Question: In a single sentence, describe what this figure presents.
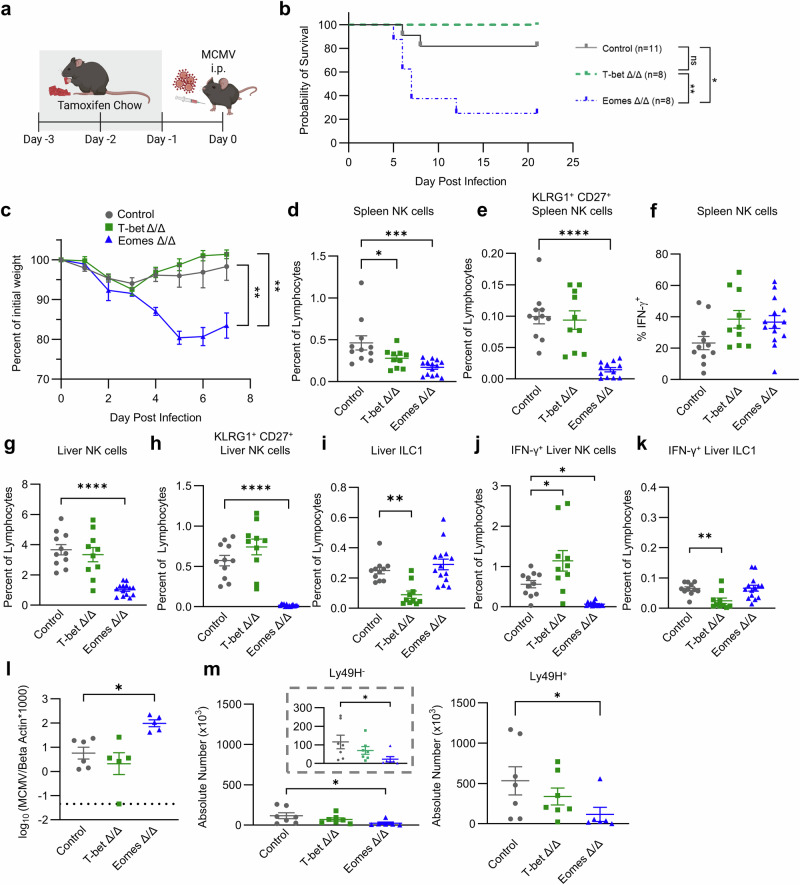
Answer: T-bet is dispensable while Eomes is required for protective group 1 ILC mediated murine cytomegalovirus (MCMV) response. a Schema. Ncr1 -iCreER T2 x Rosa26- YFP LSL x Tbx21 fl/fl (T-bet Δ/Δ), Ncr1 -iCreER T2 x Rosa26- YFP LSL x Eomes fl/fl (Eomes Δ/Δ), and N cr1 -iCreER T2 x Rosa26 -YFP LSL (control) mice were fed tamoxifen chow for 3 days. The day after tamoxifen chow was removed, the mice were infected with b , 2 ×105 pfu or (c-m) 5 ×104 pfu MCMV. Schema created in BioRender. Fehniger, T. (2026) https://BioRender.com/x3jcenb . b Kaplan-Meier survival curve ( n = 8–11 per group, female mice only). c Summary weigh loss data ( n = 4–6 per group). Summary data of d , YFP + NK cell (CD3 - NK1.1 + NKp46 + ) percentage within splenic lymphocytes ( n = 10–14 per group), e KLRG1 + CD27 + YFP + NK cells percentage within splenic lymphocytes ( n = 10–12 per group), and f percentage of IFN-γ + splenic YFP + NK cells ( n = 10–14 per group) at 1.5 days post MCMV infection. g – i percent of g, YFP + NK cell ( n = 10-14 per group), h, KLRG1 + CD27 + YFP + NK cell ( n = 10–14 per group), and i, ILC1 within lymphocytes in the liver ( n = 10–14 per group). j , k percent of IFN-γ + NK cell ( n = 10-14 per group) and ILC1 ( n = 10-14 per group) within lymphocytes in the liver. l, MCMV titer measured as IE1 copy number per Beta actin *1000 in the spleen on 4 days post infection ( n = 5–6 per group). m Absolute numbers of Ly49H - and Ly49H + NK cells in the spleen 7 days post infection ( n = 6–7 per group). Statistical significance was determined by Mantel-Cox test in b , Mixed-effect analysis with Šidák’s multiple comparison test in c for adjusted p-values, and one-way ANOVA with Dunnett’s multiple-comparisons test in d-l and Kruskal-Wallis test with Dunn’s multiple comparisons in m for adjusted p-values. 2–4 independent experiments. * = p < 0.05, ** = p < 0.01, *** p = < 0.01, **** = p < 0.0001. Exact p-values are provided in the Source Data file.